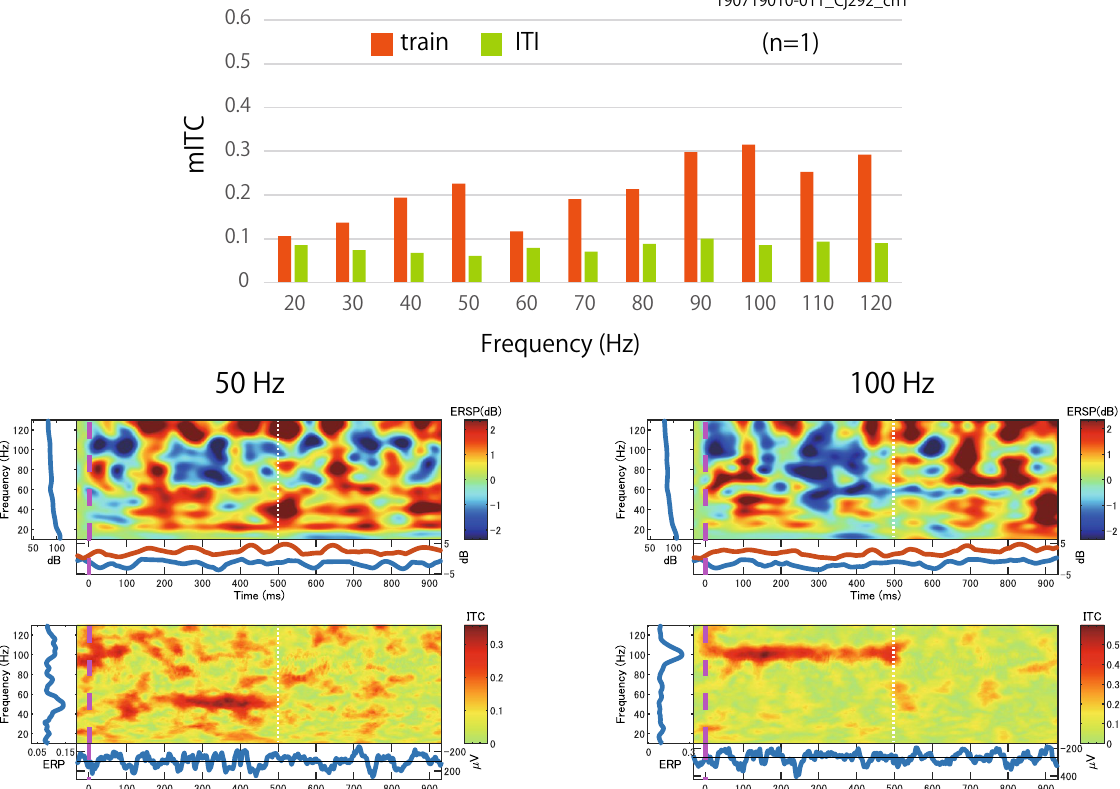
Figure 5. The mean Inter-trial coherence (mITC) values in each stimulus frequency were calculated by electrocorticography (ECoG) data from the auditory cortex of one marmoset (Cj292). Orange bars indicate the mean ITC values (mITCs) during train presentation, and light green bars indicate those during inter-train intervals (ITIs). The time–frequency plots of event-related spectral perturbation (ERSP) (upper row) and inter-trial coherence (ITC) (lower row) for the 50 Hz and 100 Hz stimulus frequency in common marmosets. The data was recorded from Ch1. The vertical purple line of time 0 indicates the beginning of the train, and the vertical white line (on time 500 ms) indicates the end of the